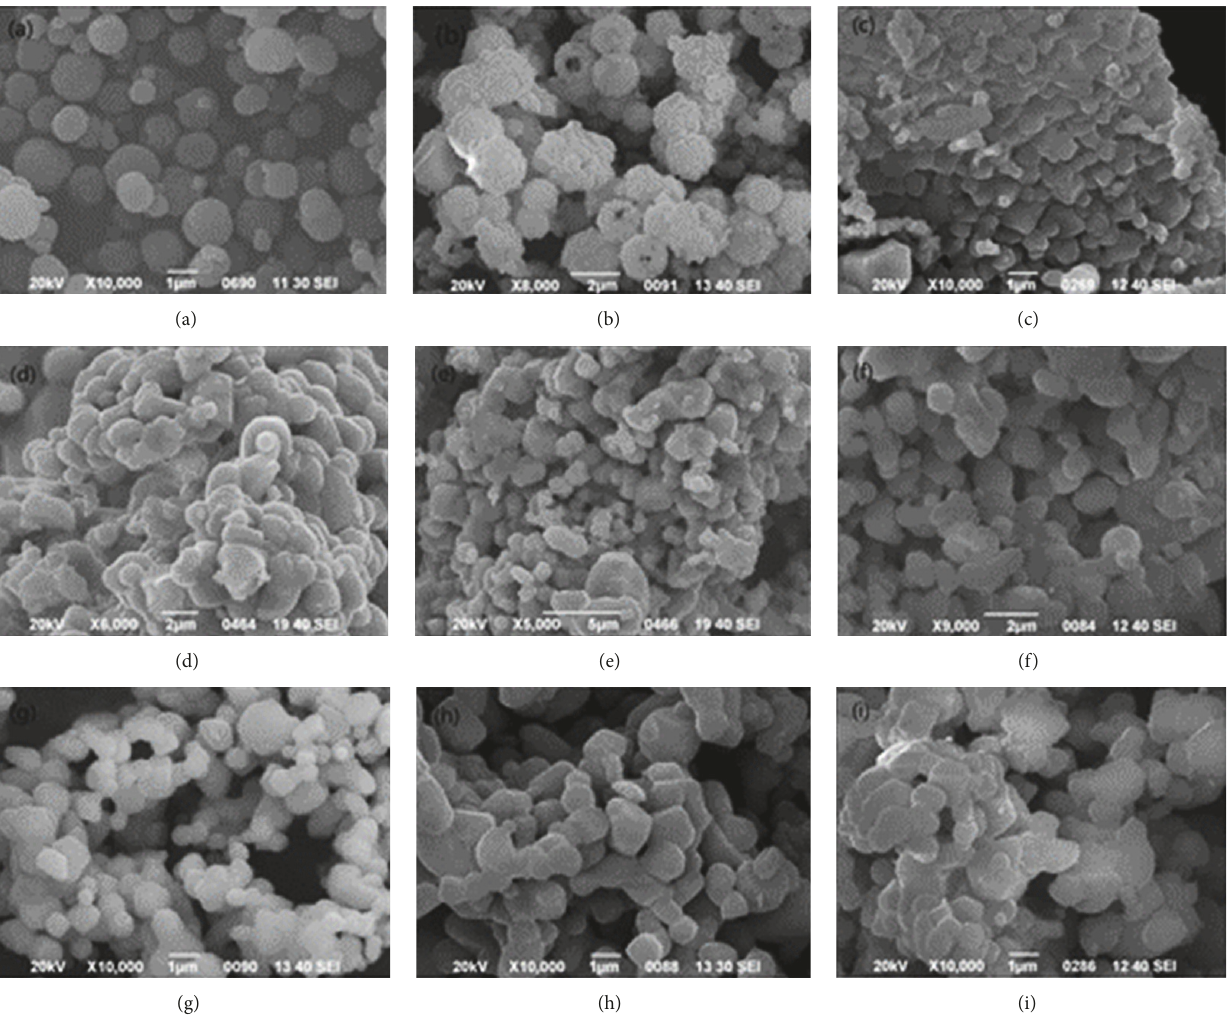
Figure 1: SEM images of (a) a completespherical shell,(b) broken MnO 2 hollow microspheres, and Li 1.25 Ni 0.2 Co 0.333 Fe 0.133 Mn 0.333 O 2 samples for (c) x = 0.0 wt%, (d) x = 2.5 wt%, (e) x = 5.0 wt%, (f) x = 7.5 wt%, (g) x = 10.0 wt%, (h) x = 12.5 wt%, and (i) x = 15.0 wt%.